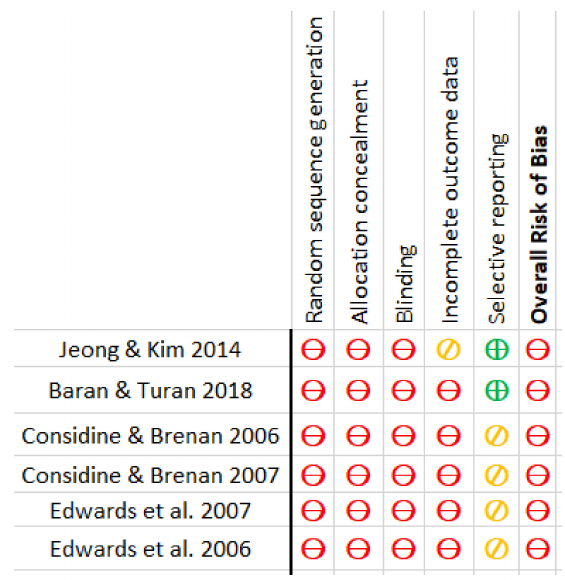
Figure 5. Risk of